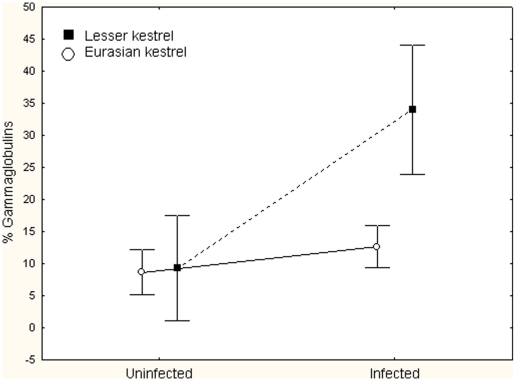
Gammaglobulin levels in infected and uninfected kestrels.Differences in gammaglobulin levels (percentage of total proteins) between kestrels uninfected and infected by Chlamydophila abortus (Chlamydophila psittaci serovar I). The interaction between infection and species is statistically significant.